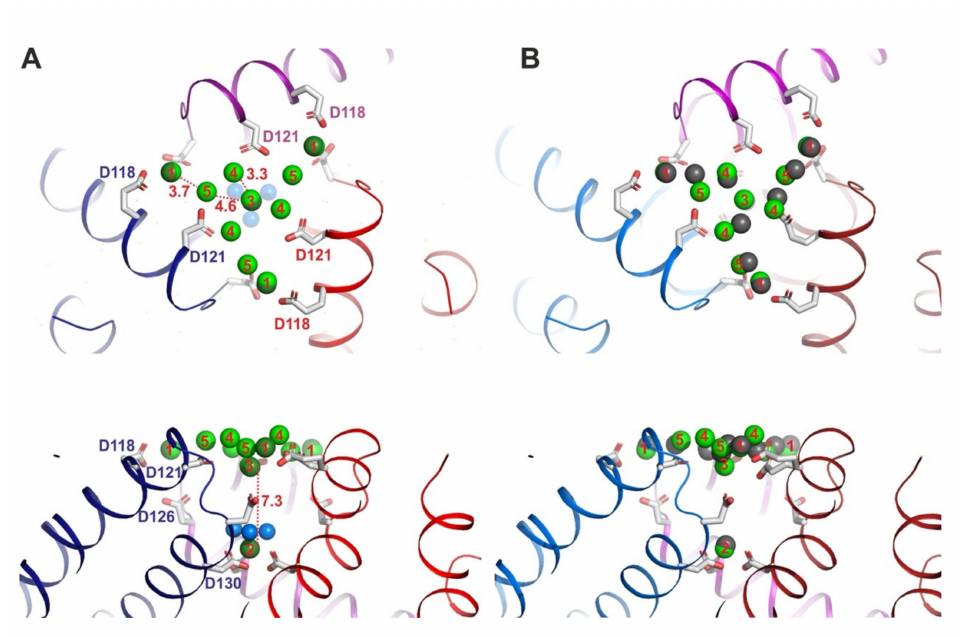
Figure 3. Architectures and uptake mechanism of Yb 3+ ions through the T1 uptake pore of Li Dps with Yb 3+ after 120 min of soaking (Dps Yb 120). ( A ) Architecture of the T1 pore viewed from the top of Dps Yb 120 in cartoon representation (upper figure). Yb 3+ ions are shown as light green spheres with positions termed 1–5. The residues of one subunit interacting with ions along the 3-fold axis are represented by sticks and marked according to the amino acid sequence. Architecture of the T1 pore viewed from the side (lower figure). ( B ) Architecture of the T1 pore viewed from the top with superimposed Yb 3+ and La 3+ ions. La 3+ ions and water molecules are shown as black and blue spheres. The dotted red line indicates the distance from position 2 to position 3. Architecture of the T1 pore viewed from the side (lower figure).